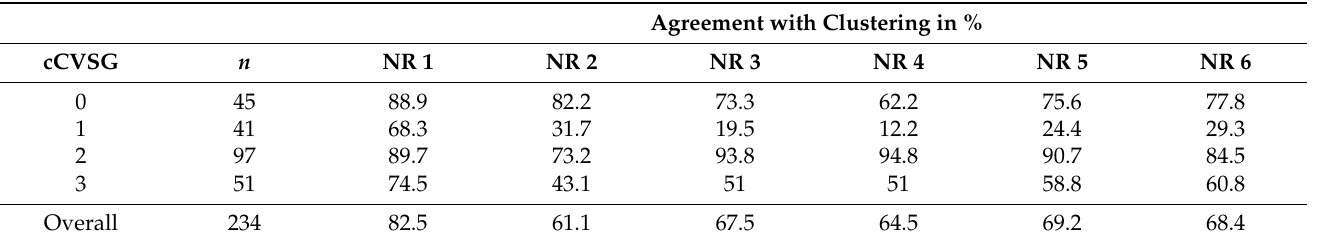
Table 3. Agreement of visual classification and mathematical